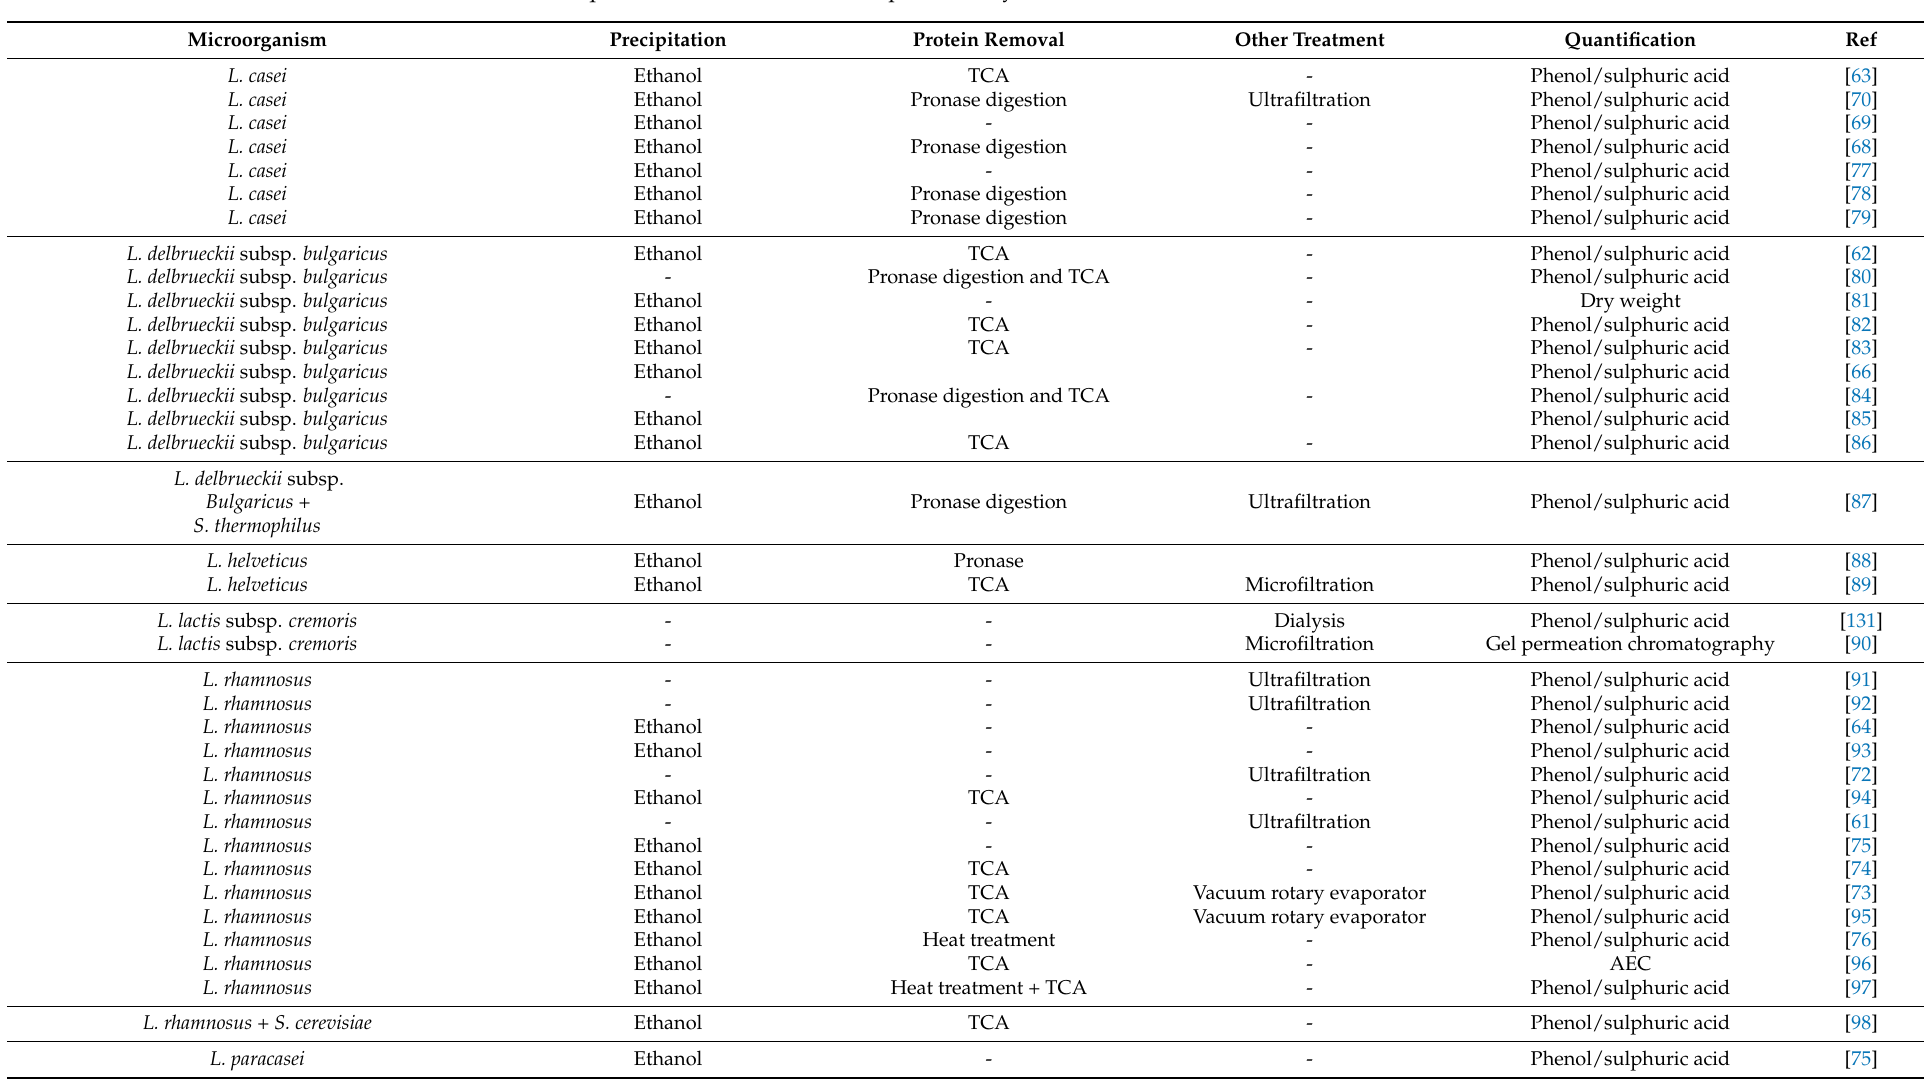
Table 2. Purification and quantification methods of EPS produced by